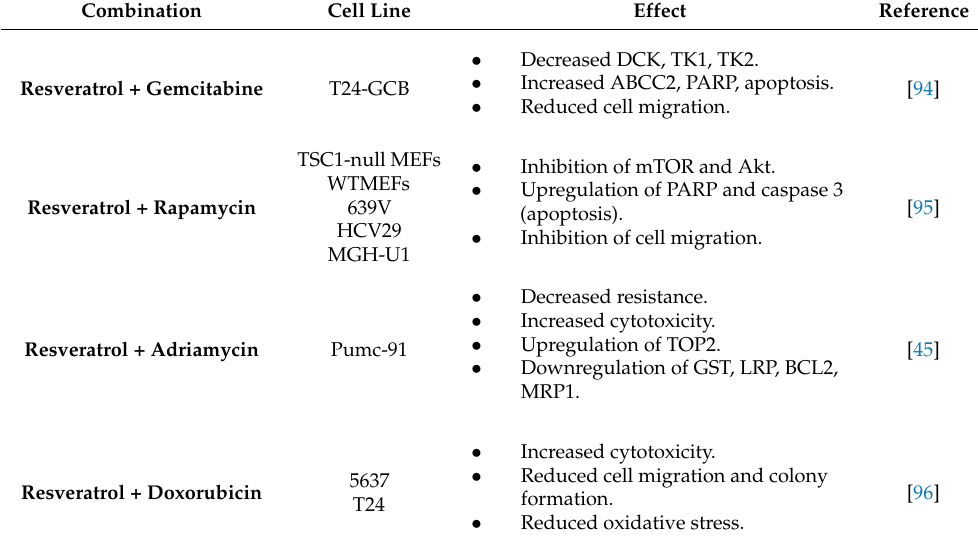
Table 1. Effects of treatment with resveratrol in combination with different drugs in bladder cancer cell lines. The table describes the effects of the combination between resveratrol and other com- pounds in the treatment of bladder cancer. DCK = deoxycytidine kinase; TK1 = thymidine kinase 1; TK2 = thymidine kinase 2; ABCC2 = ATP binding cassette subfamily C member 2; PARP = poly (ADP-ribose) polymerase; mTOR = rapamycin kinase; Akt = AKT serine/threonine kinase 1; TOP2 = DNA topoisomerase II; GST = glutathione S-transferase; LRP = LDL receptor-related protein; BCL2 = BCL2 apoptosis regulator; MRP1 = multidrug resistance-associated protein